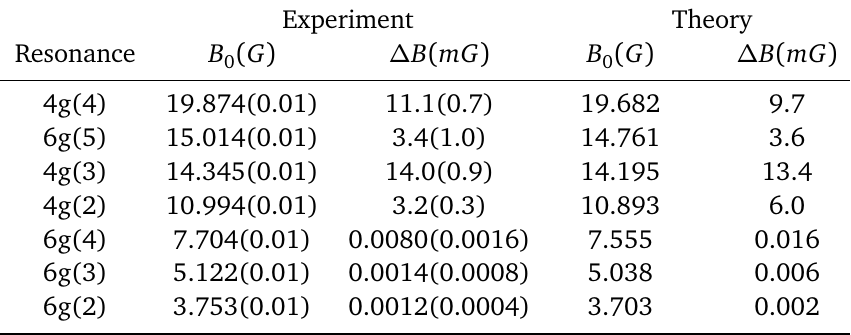
Table 1: Experimentally determined and theoretically predicted Feshbach resonance positions and widths [ 28 ] . Note that the values and error bars for resonances < 10G are the bare fit values. We estimate an uncertainty region of 0 − 20 µ G for those